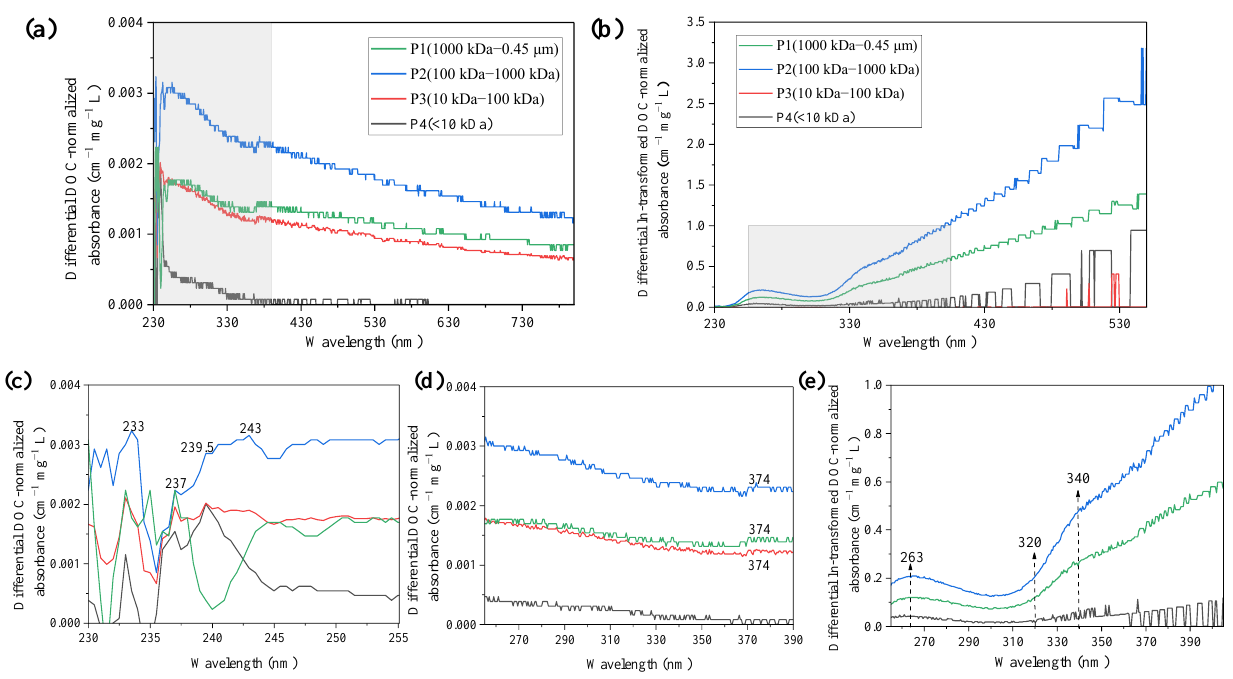
Figure 4. DOC-normalized differential and ln-transformed spectra of the PPFA induced by Fe(III) at varying molecular weight. ( c , d ) are enlarged details of ( a ), ( e ) is enlarged details of ( b ). The addition of iron concentrations for P1–P4 were 10.80, 10.07, 10.13 and 10.30 µ mol · L − 1